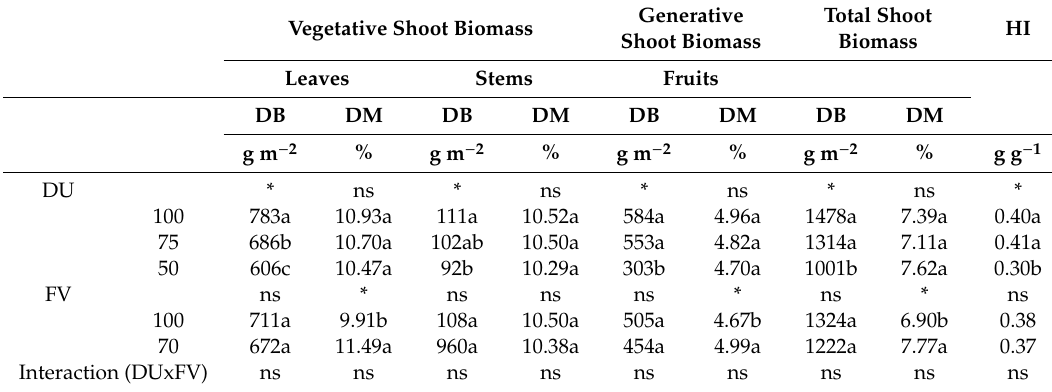
Table 3. Vegetative, generative and total shoot biomass and harvest index (HI). Dry Biomass (DB) in g m − 2 and Dry Matter (DM) in %. Vegetative Shoot